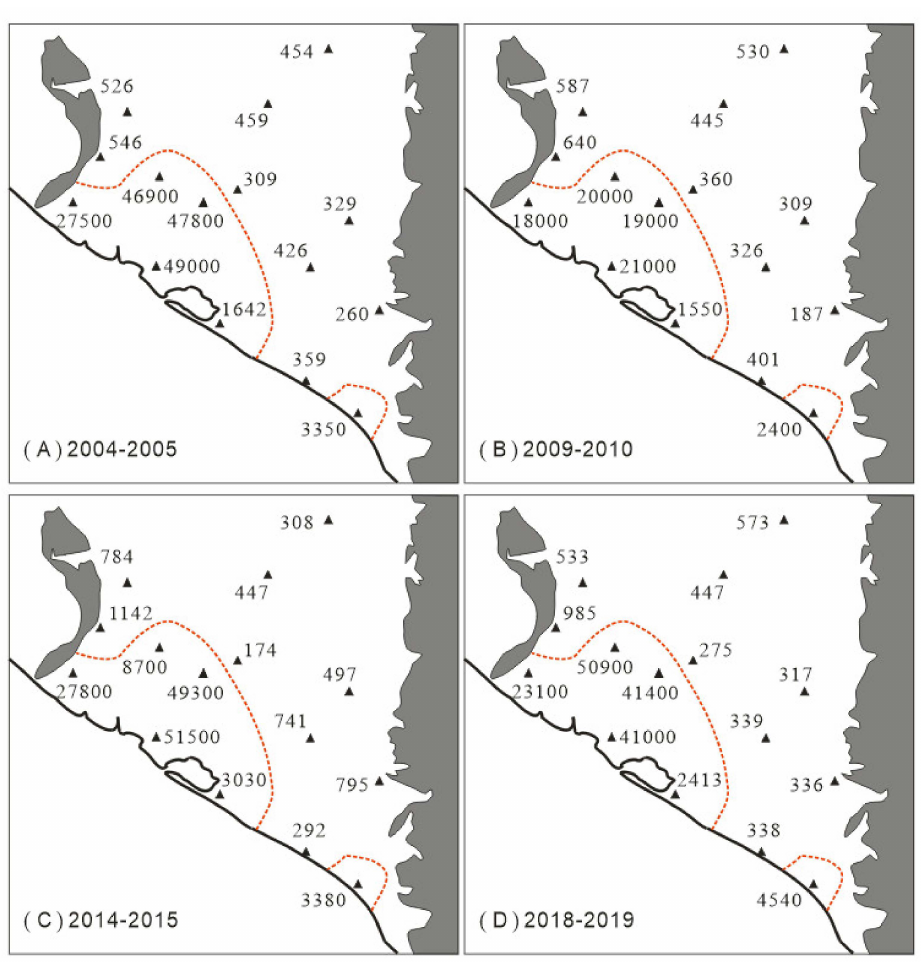
Figure 7. The groundwater EC ( µ S/cm at 25 ◦ C) in the F3-2 during 2004–2019. The area marked by a red dashed line represents a saline area in which ECs were > 1500 µ S/cm. ( A ) 2004–2005; ( B ) 2009–2010; ( C ) 2014–2015; ( D )